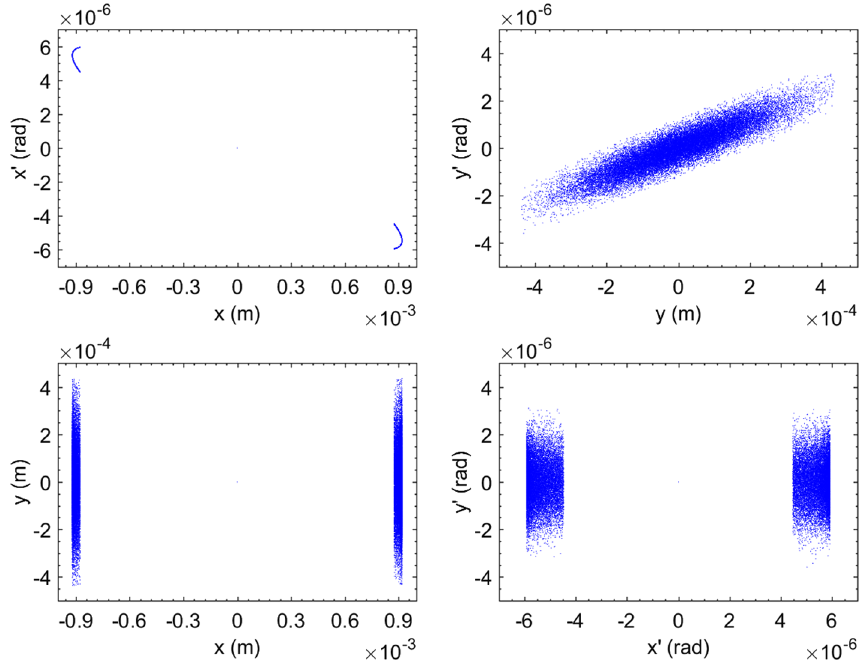
FIG. 6. Initial horizontal halo distribution for collimation